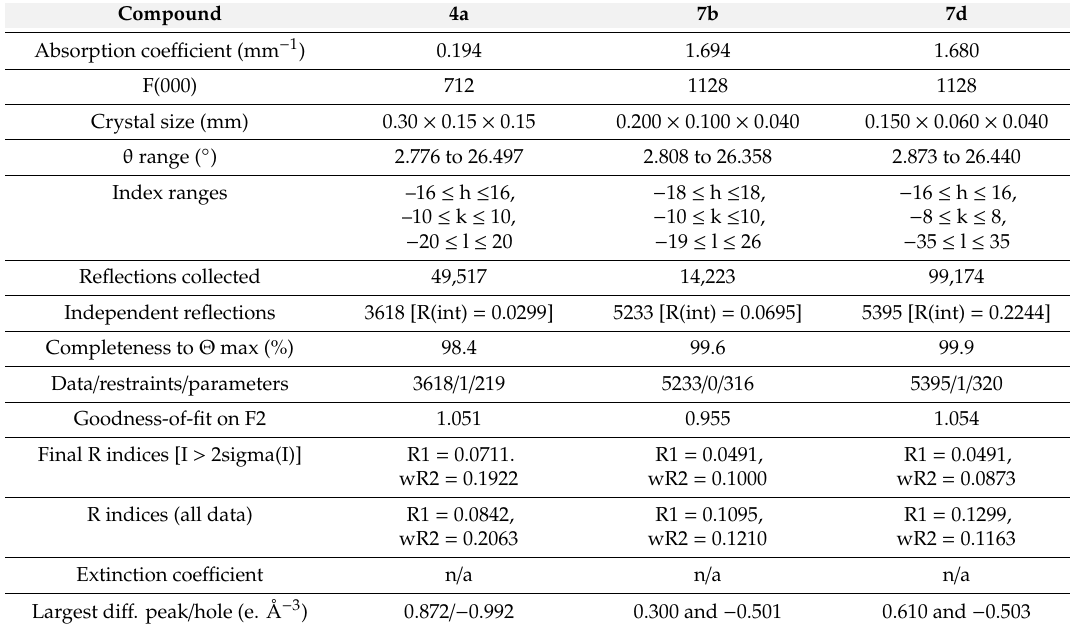
Table 6. Structure refinement data of compounds 4a , 7b , and